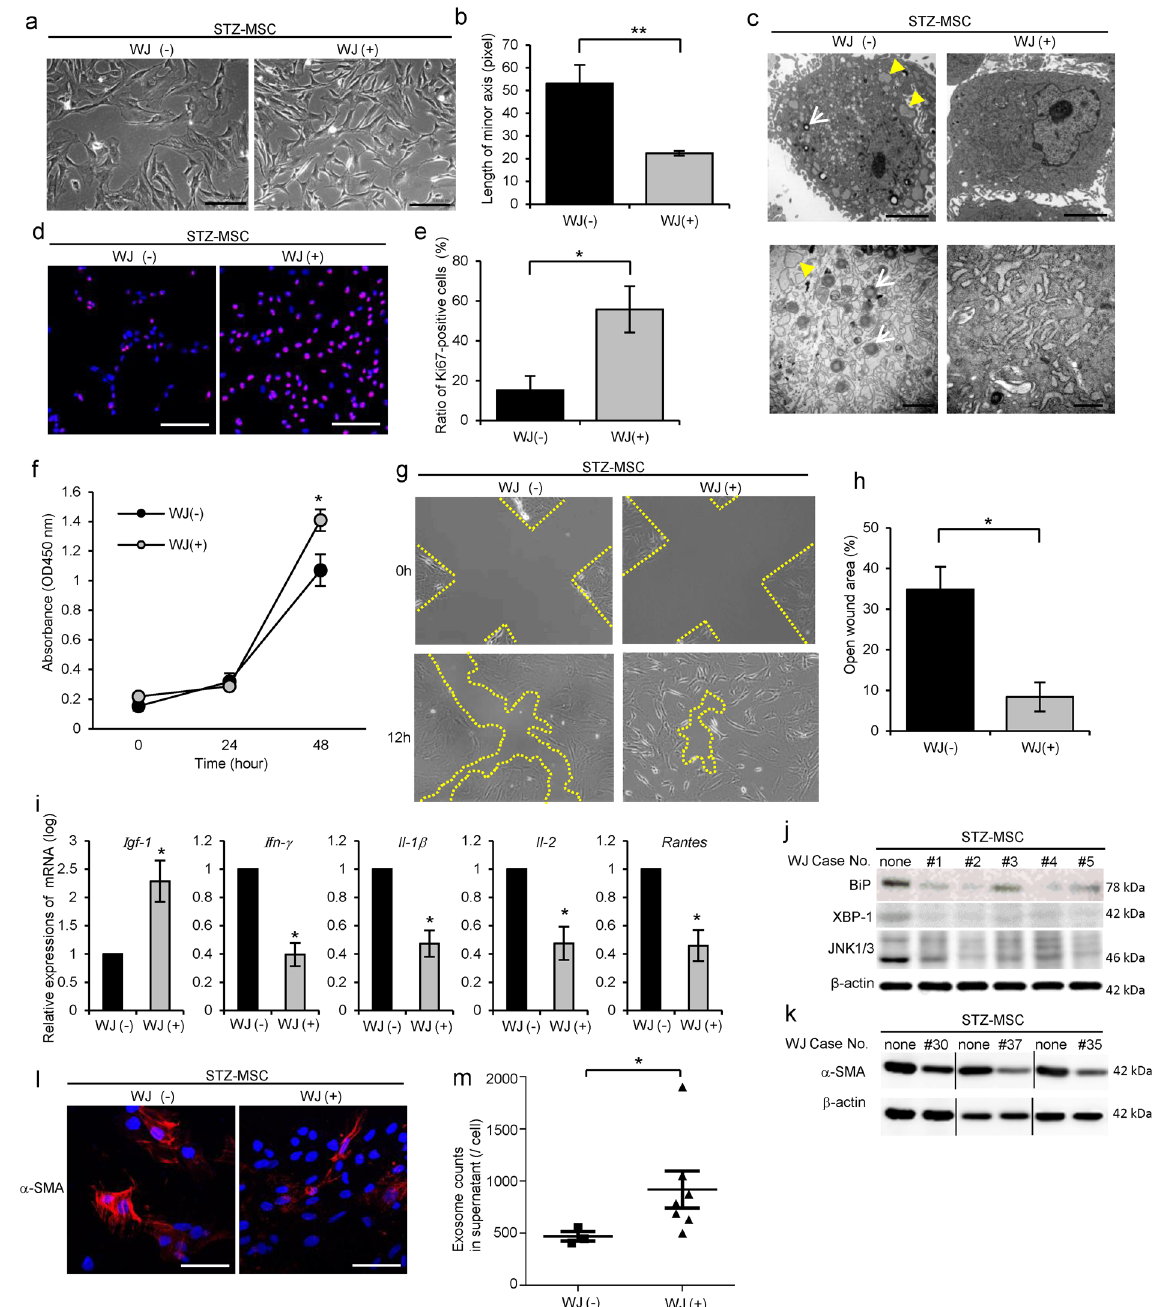
Figure 5. Activating effects of WJs for STZ-MSC. ( a ) Phase contrast images of STZ-MSC. Bar: 100 µ m. ( b ) The average length of minor axis of cells in phase contrast images. All cells in five panels of each STZ-MSC were measured. N = 4, each. ** P < 0.01. ( c ) TEM images of STZ-MSC. White arrows show mitochondrial degeneration. Yellow arrowheads show abnormal dilation of the ER. Bar: 5 µ m in upper panels; 500 nm in lower panels. ( d ) Immunofluorescence staining of STZ-MSC with Ki-67 antibody (red). Nuclei counterstained with DAPI (blue). Bar: 100 µ m. ( e ) Average ratio of Ki-67-positive cells to total cell count in five panels of each STZ- MSC. N = 3, each. * P < 0.05. ( f ) MTT proliferation assays of STZ-MSC. Absorbance was measured 0, 24 and 48 hours after MTT addition. WJ( − ); n = 7, WJ( + ); n = 29. * P < 0.05. ( g ) STZ-MSC scratch assay. The open wound area was measured immediately and 12 hours after performing the cross-scratch. Yellow lines indicate the cell mobilization edge. ( h ) The ratio of open wound area at 12 hours compared with 0 hours. Five cross- scratch points in each STZ-MSC were measured. N = 3, each. * P < 0.05. ( i ) Relative expressions of mRNA in STZ-MSC. WJ( − ); n = 4, WJ( + ); n = 12. * P < 0.05. ( j ) Western blot analysis of STZ-MSC cultured with 5 lots of WJs (#1–5) or without WJs using anti-BiP, anti-XBP-1, anti-JNK1/3 and β -actin antibodies. The cropped images of immunoblots displayed in the figure and the full-length blots were shown in Supplementary Fig. S14. (k) Western blot analysis of STZ-MSC cultured with 3 lots of WJs (#30, 37, 35) or without WJs using anti- α